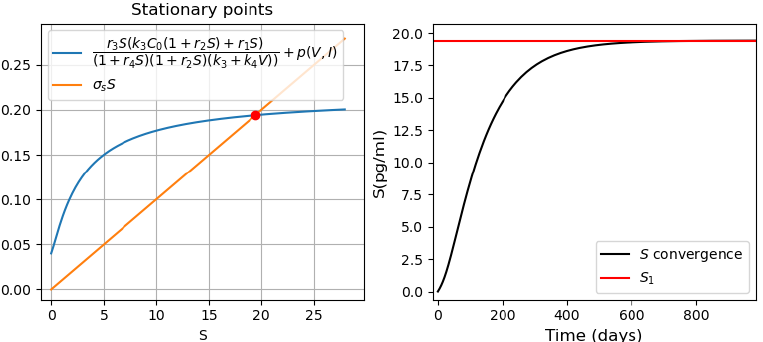
Figure 10. Left : graphical solution of Equation (32) in monostable case. Right : convergence of the concentration of proinflammatory cytokines to their stationary value, S ( 0 ) = 0. The values of parameters: r 1 = 1.4, r 2 = 0.8, r 3 = 1, r 4 = 0.5, σ S = 0.01, p 1 = 0.4, p 2 = 10, p 3 =